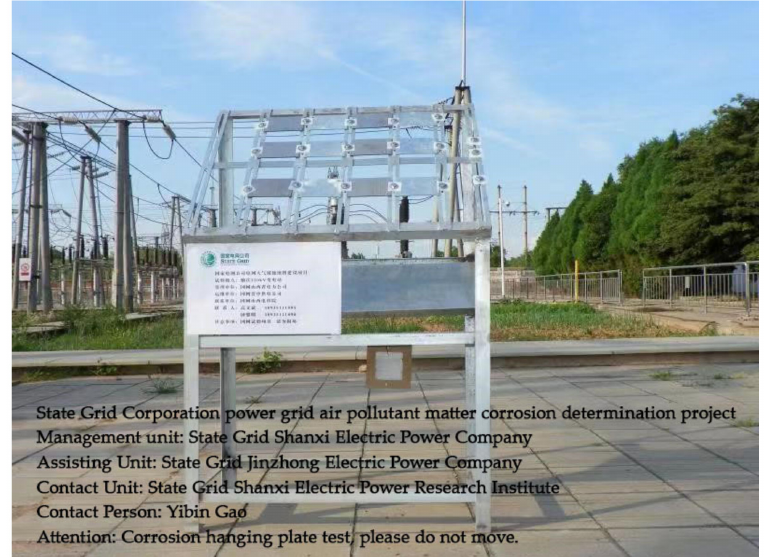
Figure 2. Diagram of hanging plate experimental